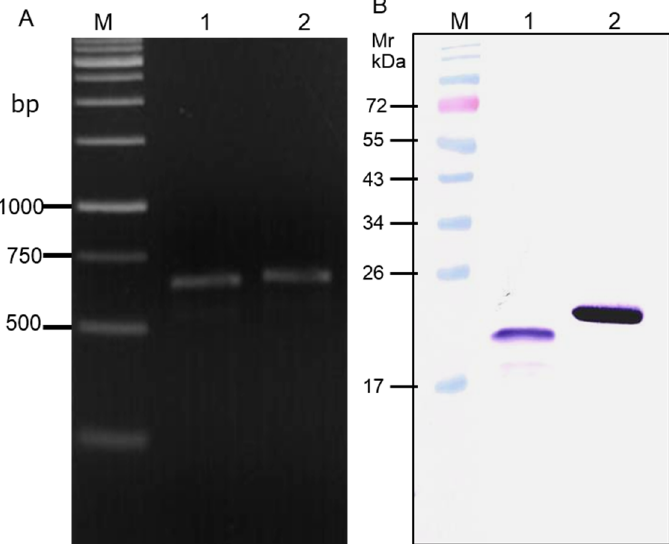
Figure 4. Preparation of cell penetrable nanobody (transbody). ( A ) Amplicons of the gene sequences coding for V H H24 and PEN-V H H24 (lanes 1 and 2, respectively). The latter